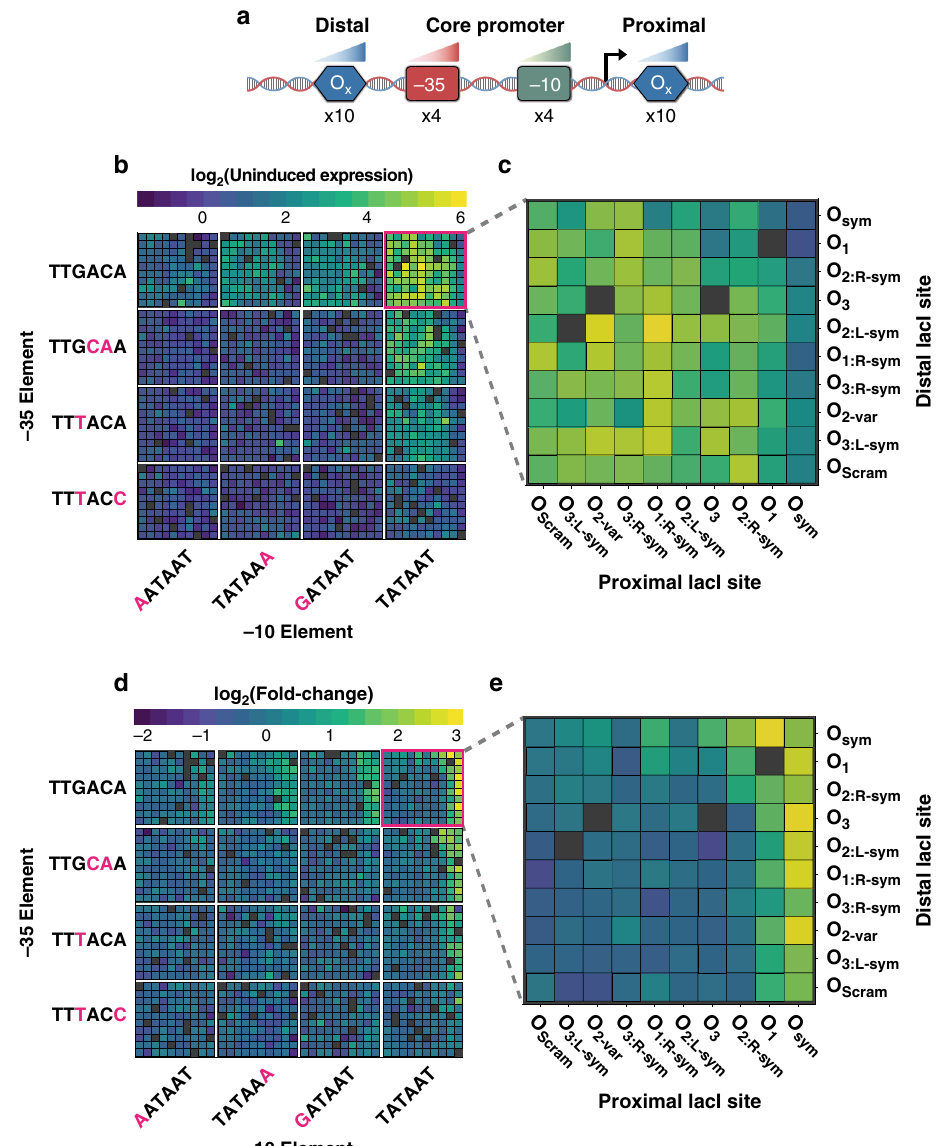
Fig. 2 Tuning binding site strengths alters inducible promoter behavior. a Pcombo library schematic consists of all combinations of one of ten proximal LacI-binding sites, four − 10 elements, four − 35 elements, and ten distal LacI sites. b Uninduced MPRA expression for all assayed Pcombo variants. Grid positions for the − 10 and − 35 motifs are arranged according to median induced expression, from the weakest to consensus sites ( − 10:TATAAT and − 35: TTGACA). Gray boxes indicate sequences that were not measured by the assay. c Uninduced expression for assayed Pcombo variants containing consensus σ 70-binding sites. d Fold change for all assayed Pcombo variants. Fold change is determined by the ratio of MPRA expression at 1 mM IPTG relative to 0 mM IPTG. e Fold change for all assayed Pcombo variants containing consensus σ 70-binding sites. Source data are available in the Source Data fi